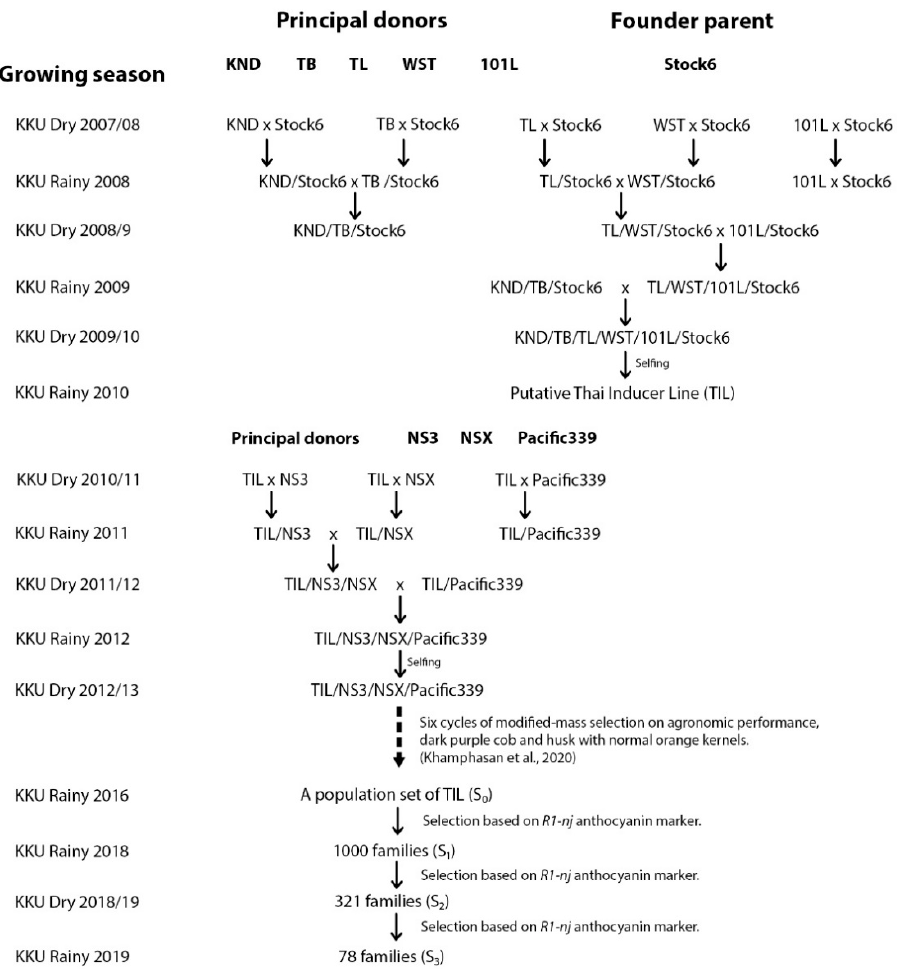
Figure 1. Breeding framework to establish a population set of 78 putative haploid inducer families (2007–2019).